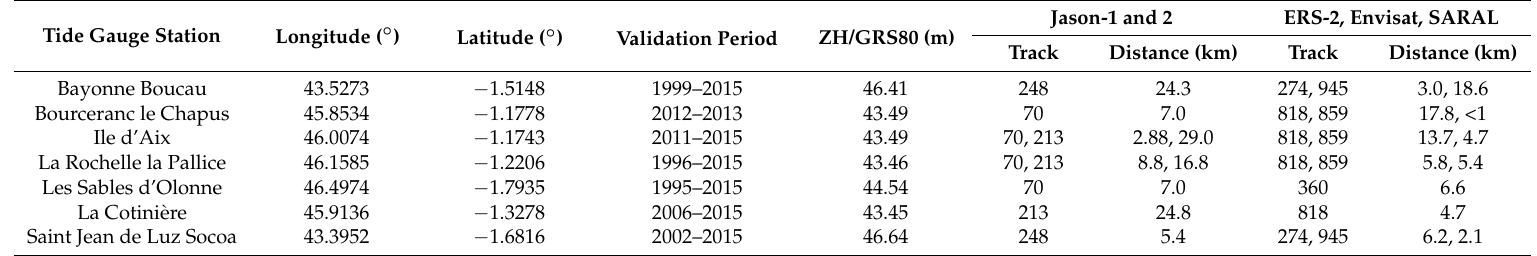
Table 1. Locations of the tide gauge stations and the available time period in the study area. Columns 6 and 7 show the satellite track number and the distance track–tide gauge. The green highlights the tracks close to the coastline (<15 km). The yellow tracks are located in a mixed domain between the coastal area and open ocean (15–25 km), and the red tracks the open ocean (>25 km).